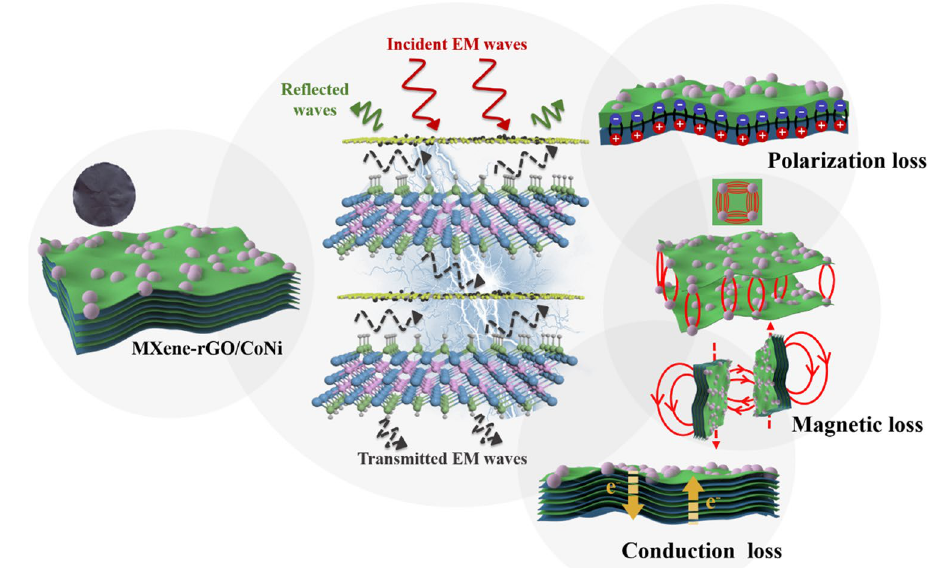
Scheme 1 Schematic illustration of MA mechanisms for MXene- rGO/CoNi